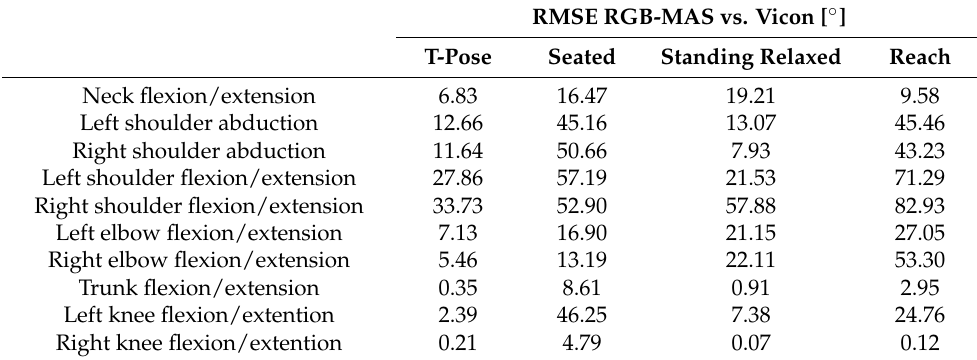
Table 3. RMSE values obtained comparing RGB-MAS angles with the Vicon ones.